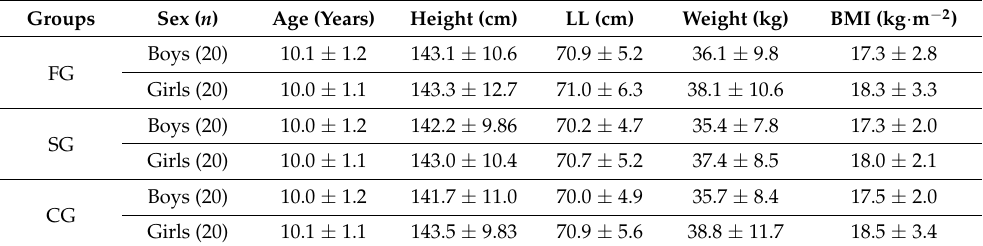
Table 1. Anthropometric and demographic characteristics for the experimental and control groups. ( n =